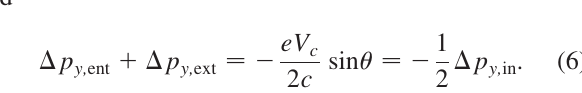
TABLE I. List of assumptions and approximations for analytic formulas. Same mean square of tilt angle for all cavities Same mean square of offset for all quadrupole magnets Energy deviation, (cid:6)E , is constant for each particle Large number of components, for taking